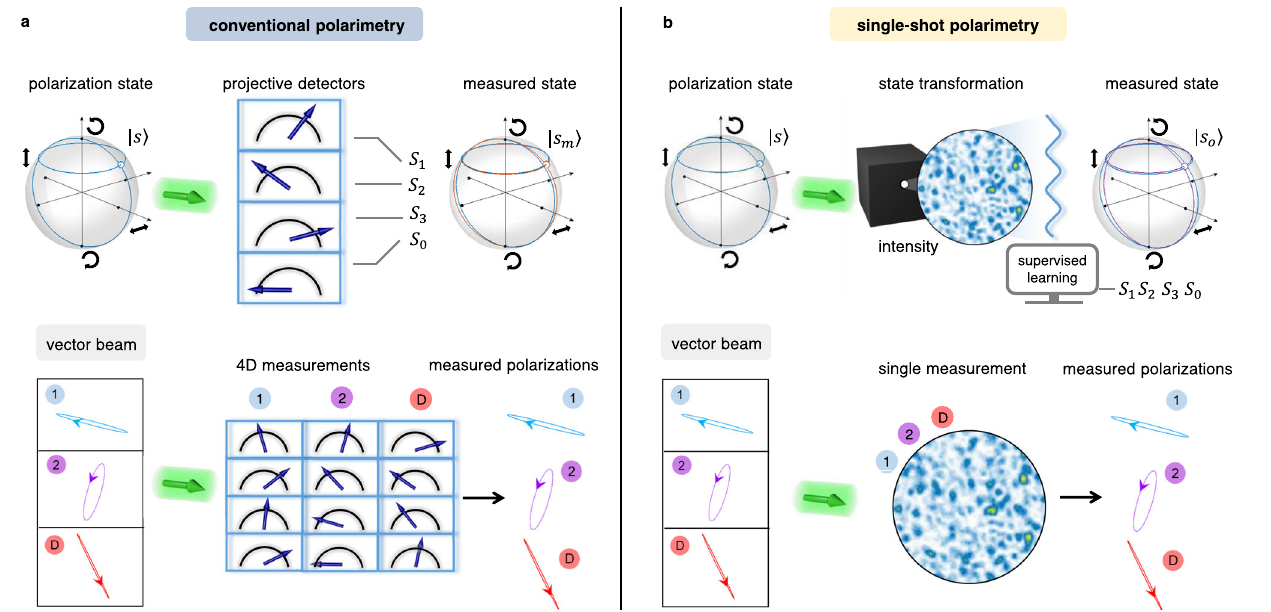
system with a polarization-dependent response: disordered media, nonlinear materials, optical devices, etc. The SOP is identi fi ed in the feature space by supervised learning. When measuring a vector beam composed by 1, 2, ..., D dif- ferent polarizations, the projective analysis necessitates 4 D measurements, while we use a single intensity distribution embedding all